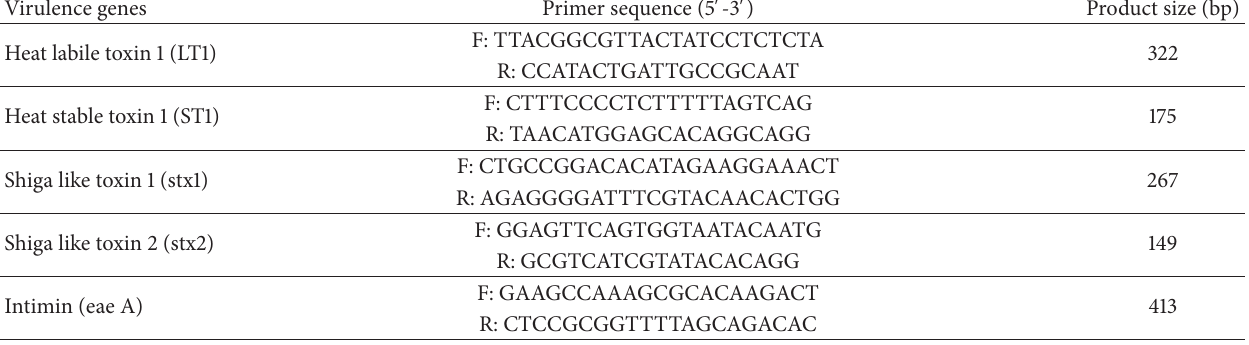
Table 1: PCR primer sequences, their related gene targets, and expected amplification products size.